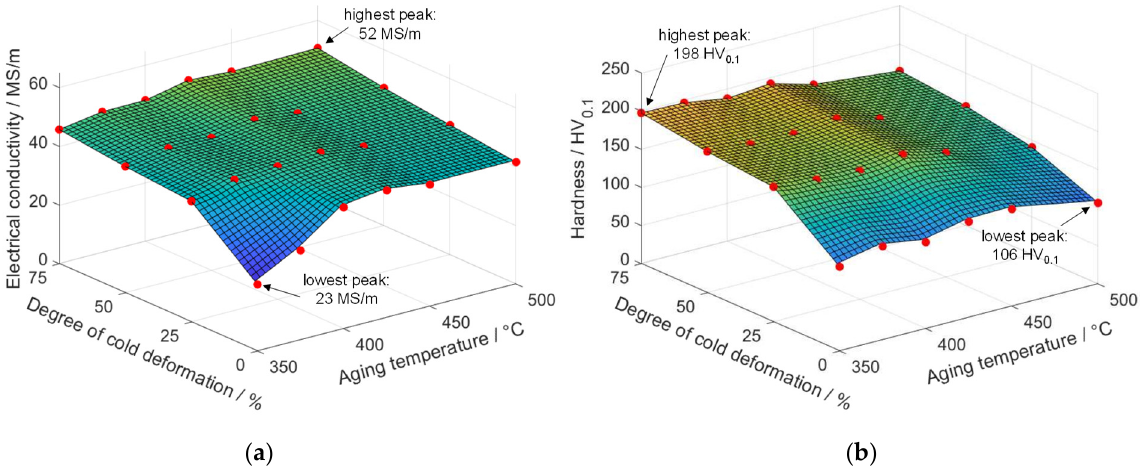
Figure 6. Properties of CuSc0.3 resulting from isothermal aging treatment at 350 °C to 500 °C up to 48 h; ( a ) maximum electrical conductivity; ( b ) maximum hardness.